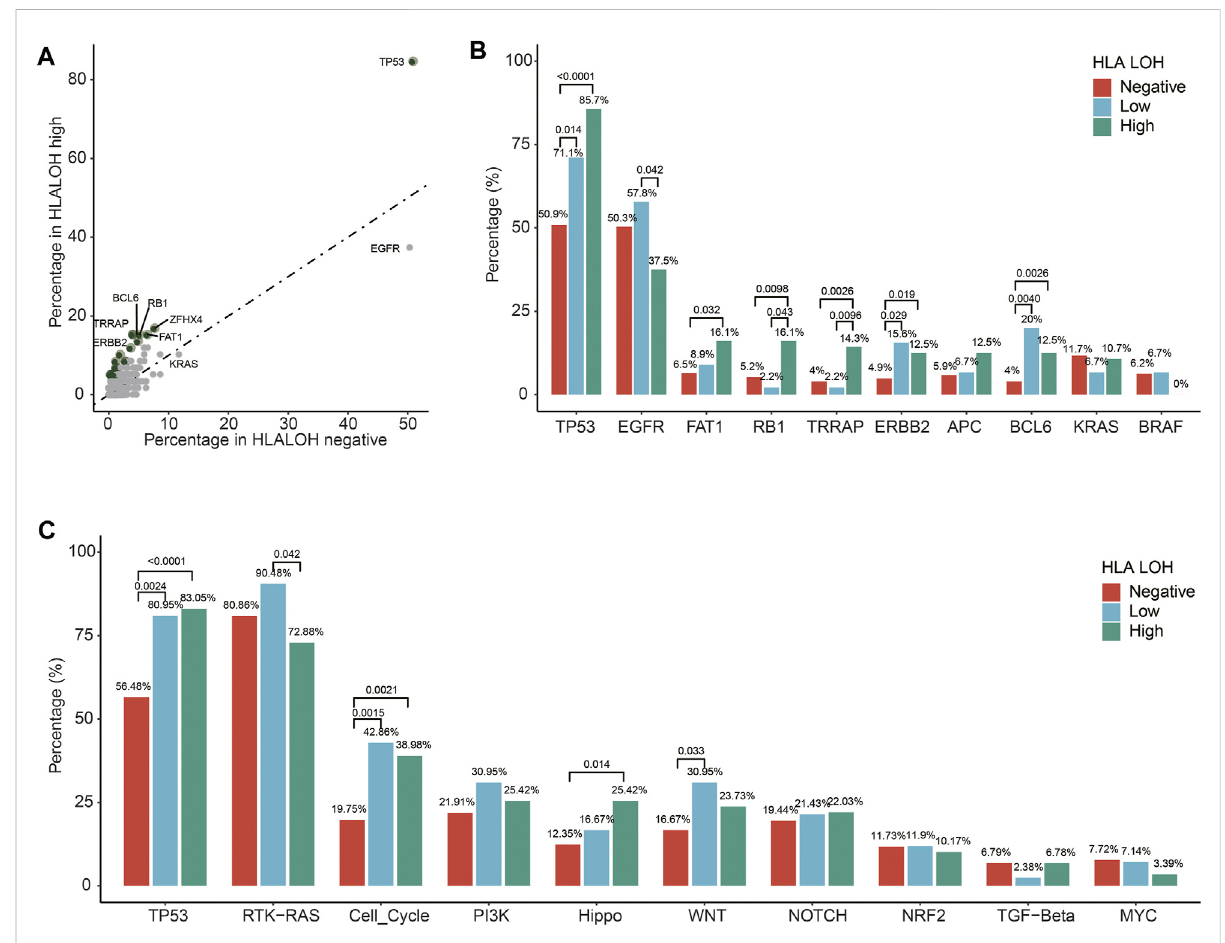
FIGURE 2 DifferentHLALOHstatusesbasedonalterationsinindividualgenesandpathways. (A) PercentagesofalteredindividualgeneswithinHLALOHhigh versus HLALOHnegativesubgroups.Greendotsdenotegenesassociatedwithsigni fi cantlydifferentialHLALOHstatuses( p -value < 0.05) (B) DistributionofHLALOH status by commonly altered genes in lung cancer. (C) Percentage of tumors harboring an alteration of individual pathways within HLA LOH